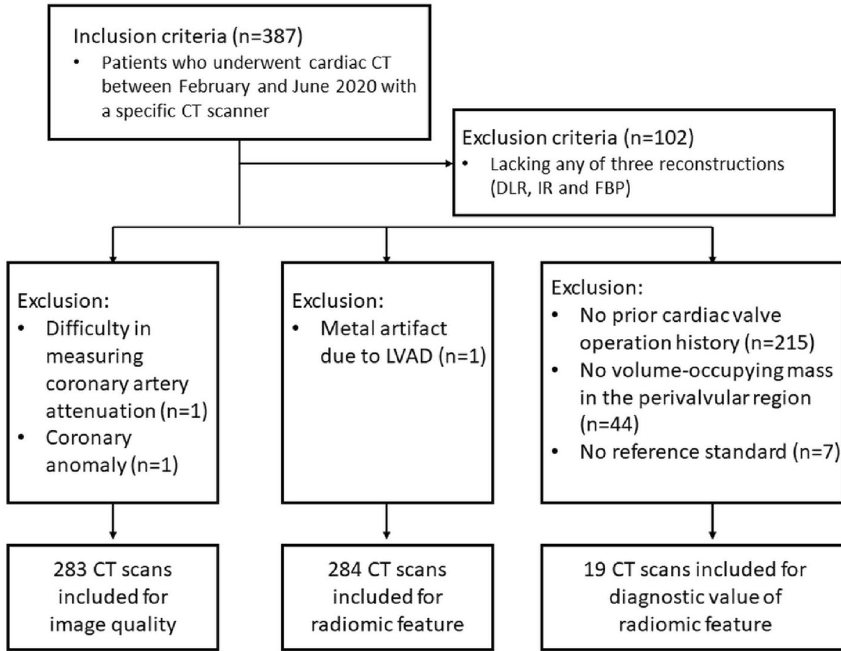
Figure 1. Flow chart for patient enrollment. LVAD, left ventricular assist device; DLR, learning-based reconstruction; IR, iterative reconstruction; FBP, filtered back